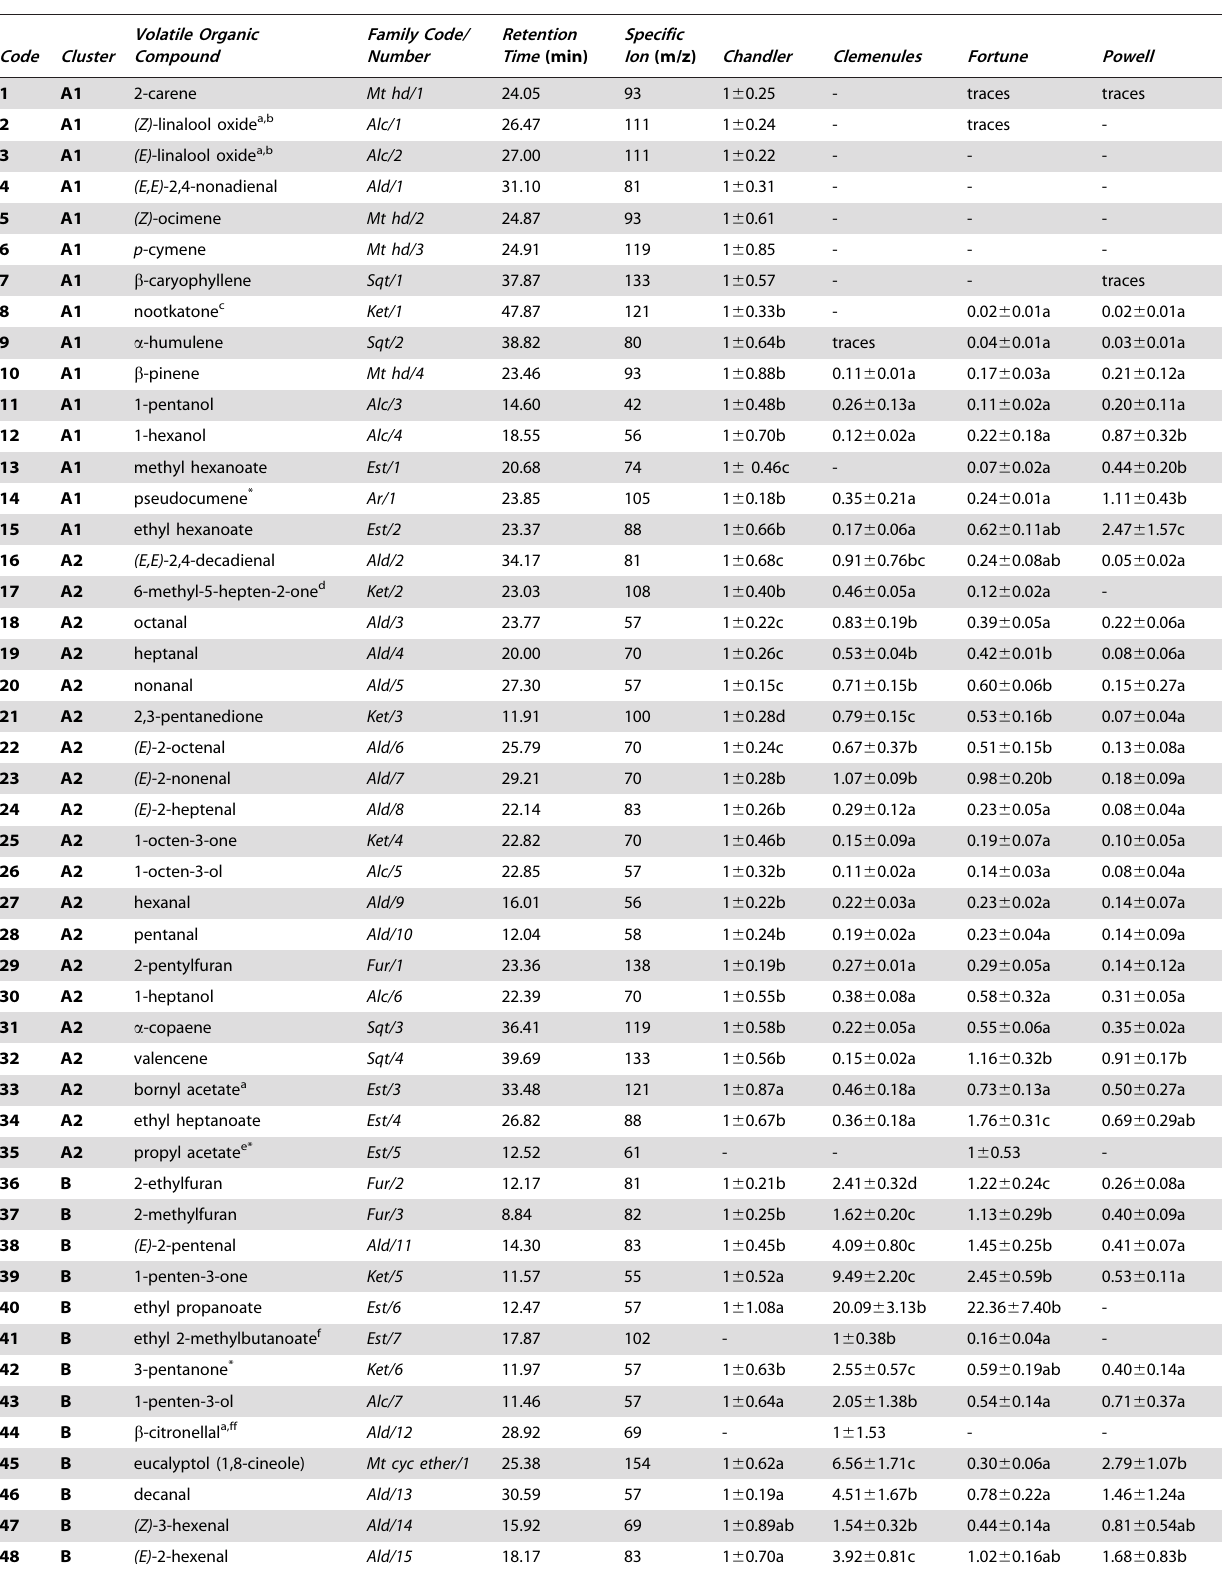
Table 1. Relative levels (fold changes) of VOCs detected in juices of four Citrus varieties.